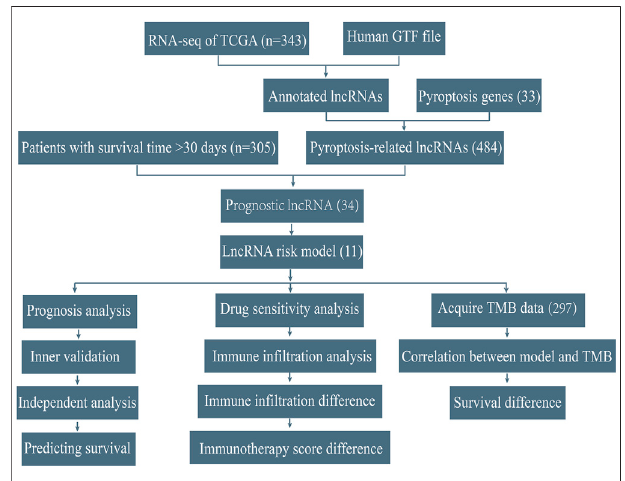
FIGURE 1 | Work fl ow of this